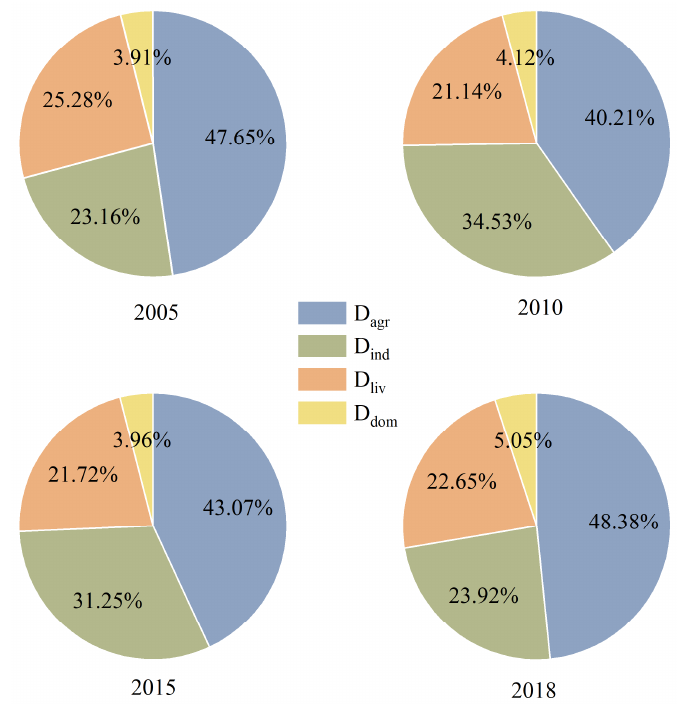
Figure 9. Sectoral water ratio of total water consumption.